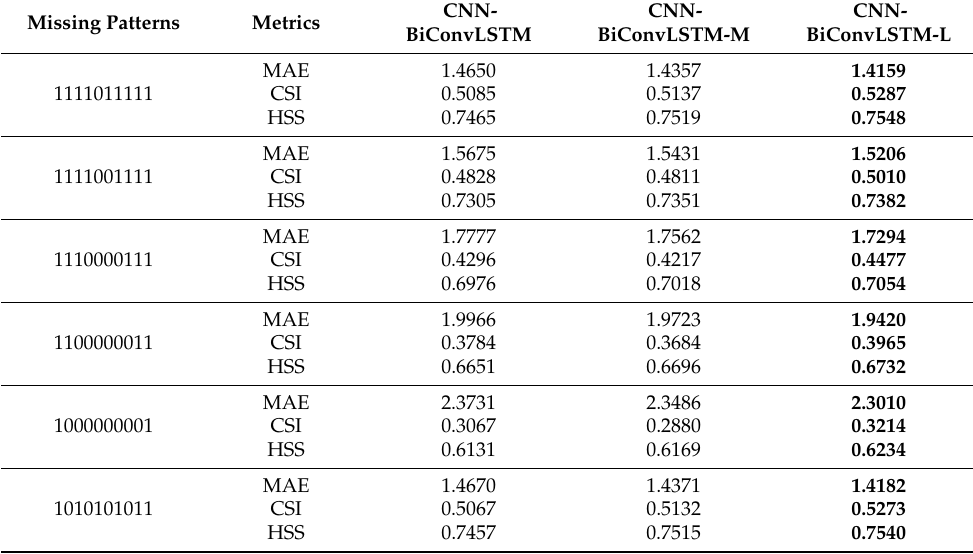
Table 3. Evaluation results of MAE, CSI-40 scores, and HSS scores for the CNN-BiConvLSTM model with different model sizes and for 6 missing patterns with respect to interpolation.